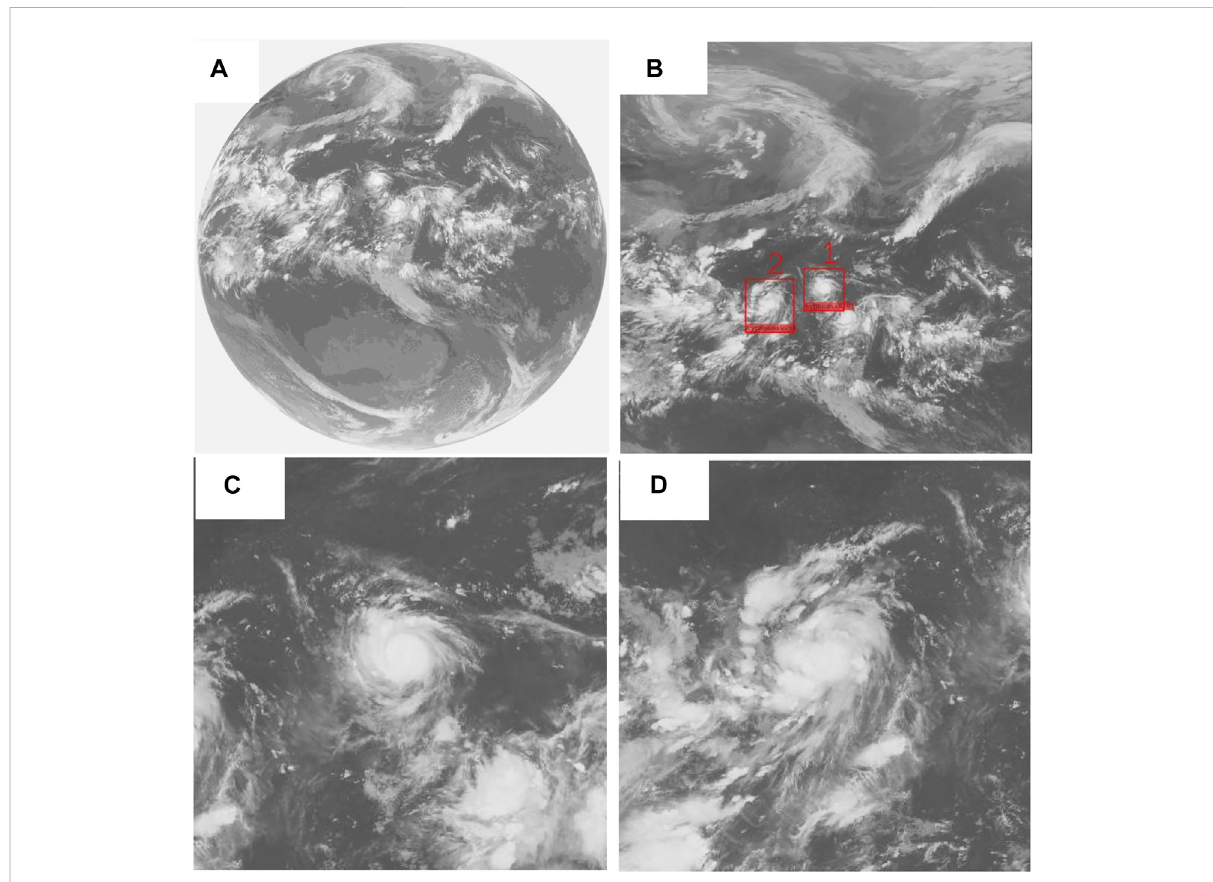
FIGURE 9 Arti fi cialintelligence-basedtyphoonmonitoringandforecastingsystem (A) FY-4Asatellite ’ sdiskmapon7September2021at12UTC (B) Range